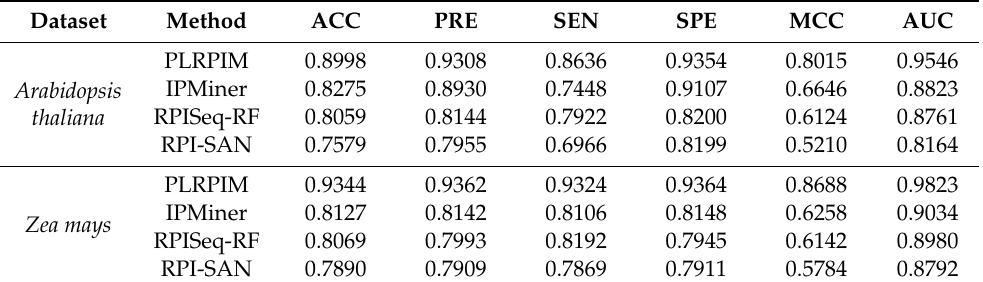
Table 5. Predictive performance of other methods and the proposed method.